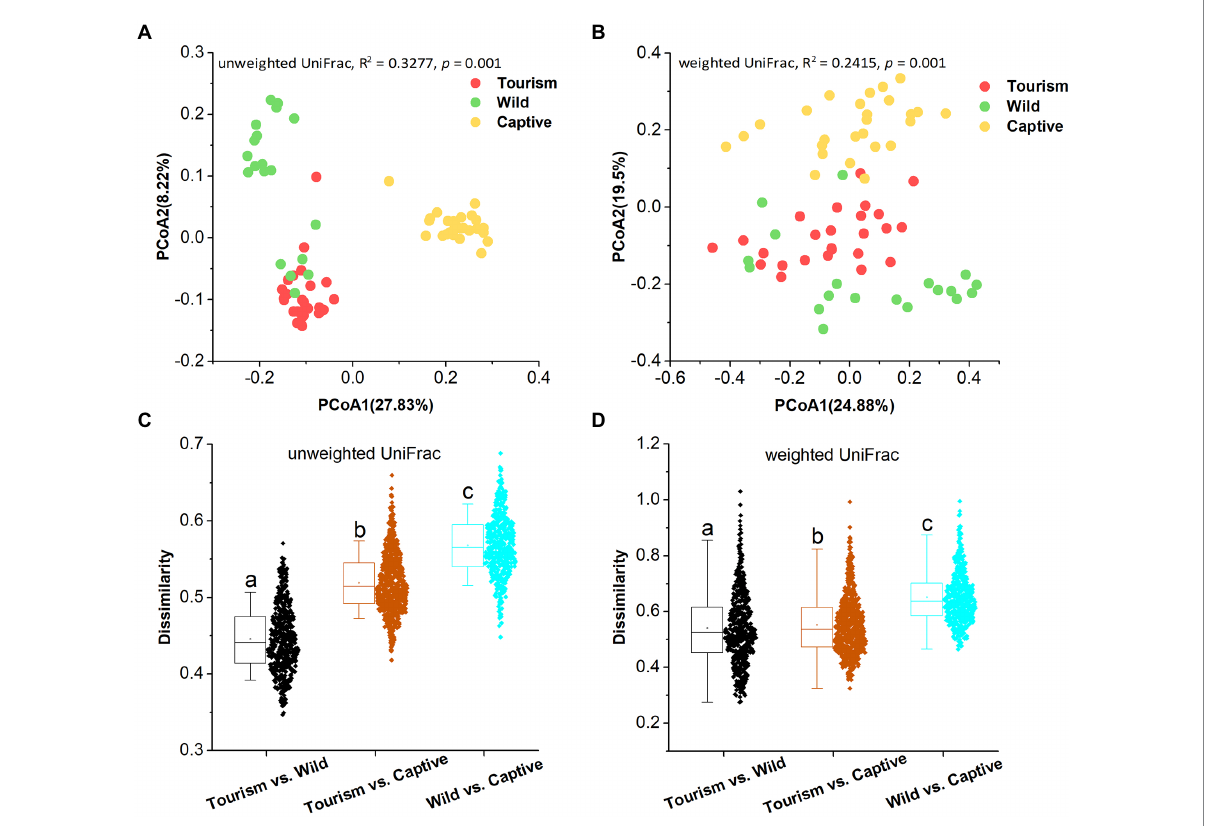
FIGURE 3 Differences in beta diversity of the gut microbiome across three study groups. (A,B) Differentiation of fecal microbiota structure. A : based on unweighted UniFrac distance, B : based on weighted UniFrac distance. PCoA was used to show patterns across three study groups. Adonis tests were performed on unweighted and weighted UniFrac, respectively. Significance was set at the 0.05 level. (C,D) Comparison of dissimilarity between Gut microbiome structures. C : based on unweighted UniFrac distance, D : based on weighted UniFrac distance. Significance was set at the 0.05 level. Letters in (C) and (D) represent significant